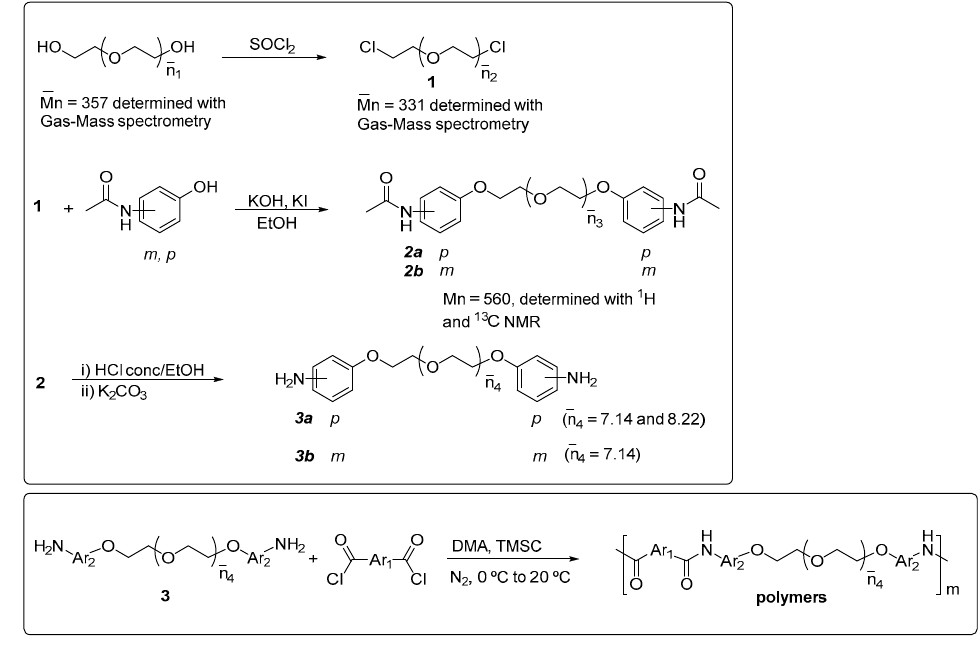
Table 1. Structure of the synthesized polymers. Scheme 1. Polymer synthesis, structure, and codes of poly (ether amide)s.